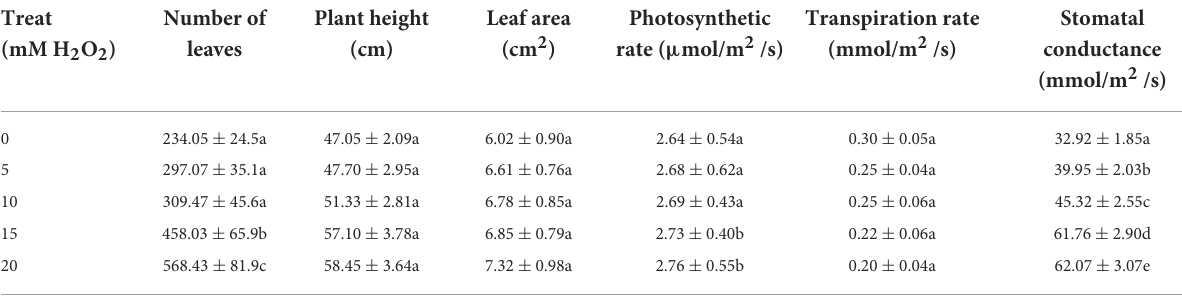
TABLE 1 The effects of H 2 O 2 treatment on plant growth and photosynthetic characteristics of drought stressed F. deltoidea plants. Treat